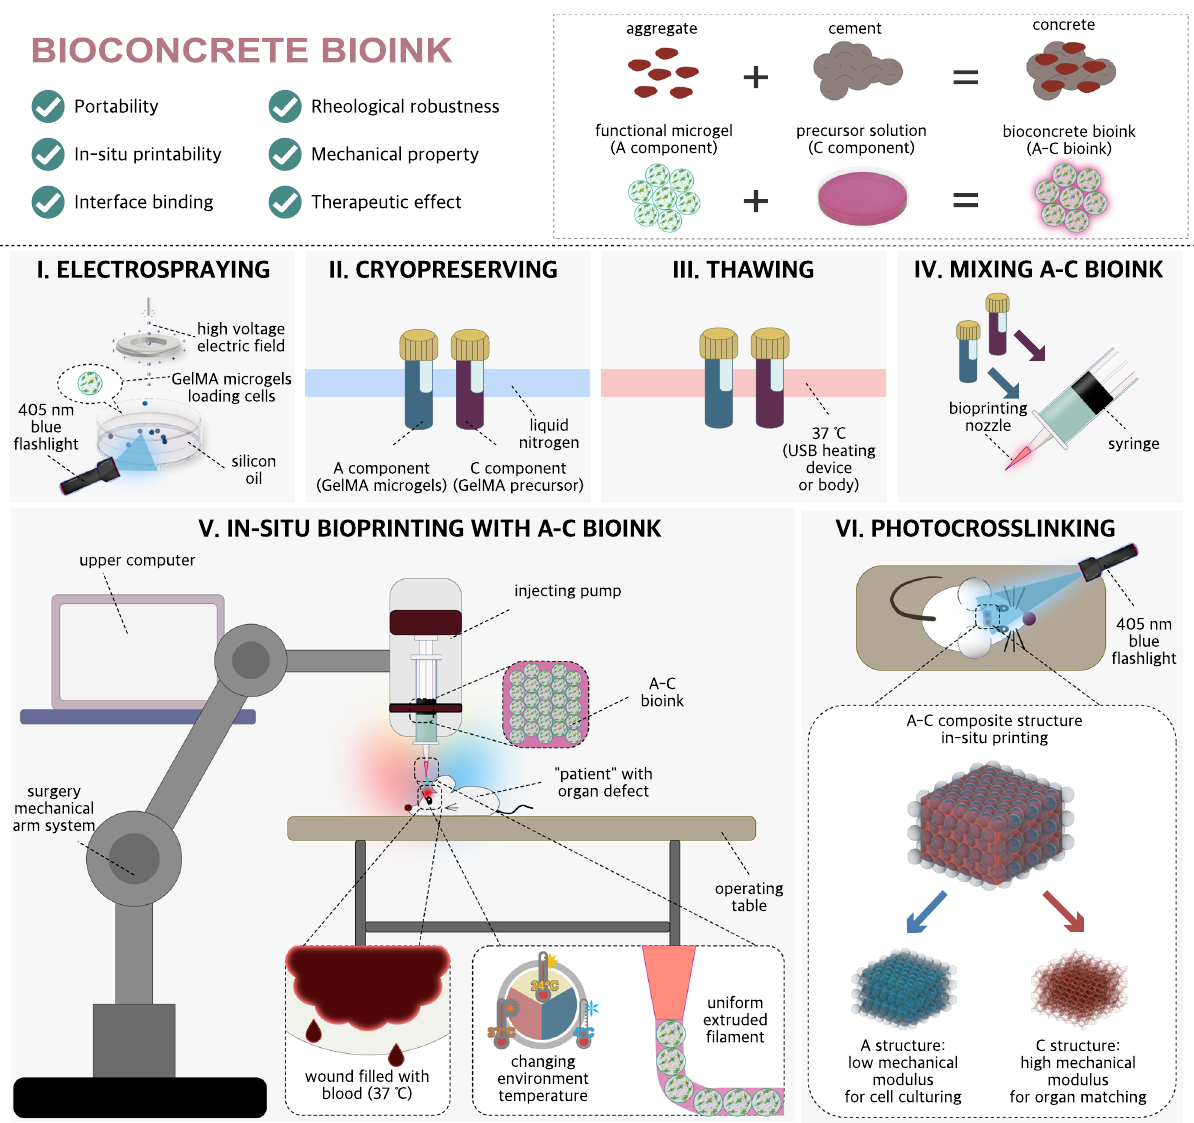
Fig. 1 Train of thought of A – C bioink designing and sketch of the preparing/using method. Upper panels show the properties of the proposed A – C bioink inspired by concrete for construction. Lower panels (I-VI) show the usage of A – C